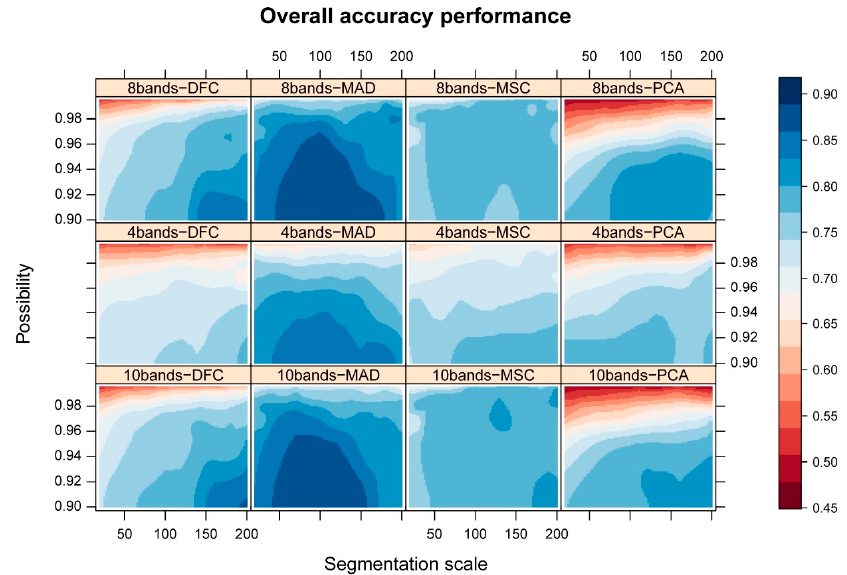
Figure 4. Overall accuracy of change detection at nineteen different segmentation scales and five confidence levels (i.e., 0.995, 0.99, 0.975, 0.95 and 0.9) using four change detection methods and three segmentation strategies, for Study site 1.